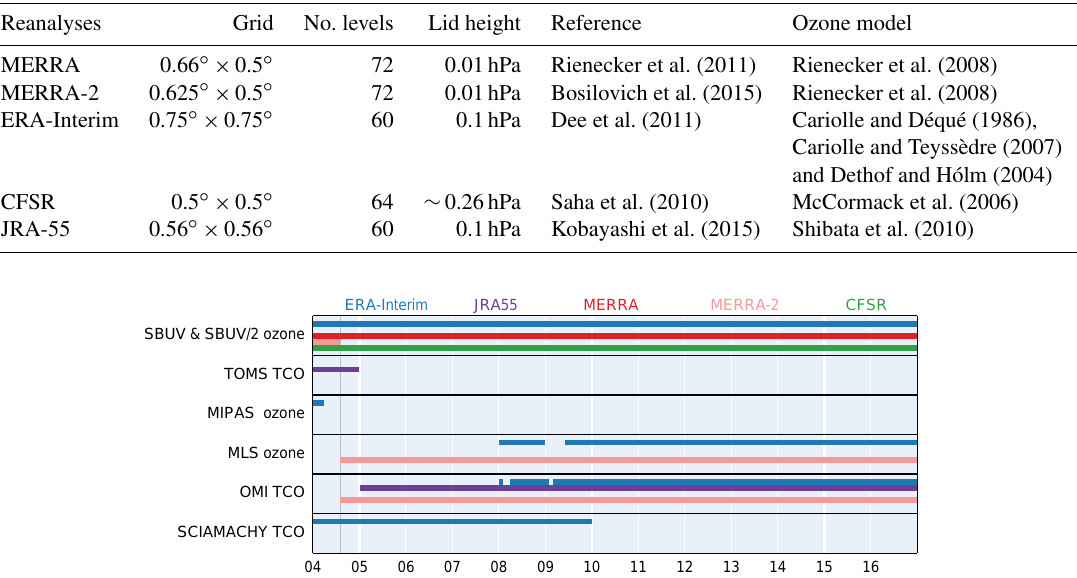
Table 1. Basic specifications of the reanalysis forecast models.